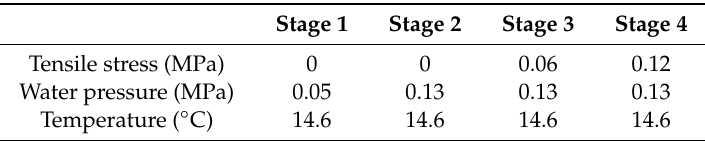
Table 2. Stage test parameters of the model test.